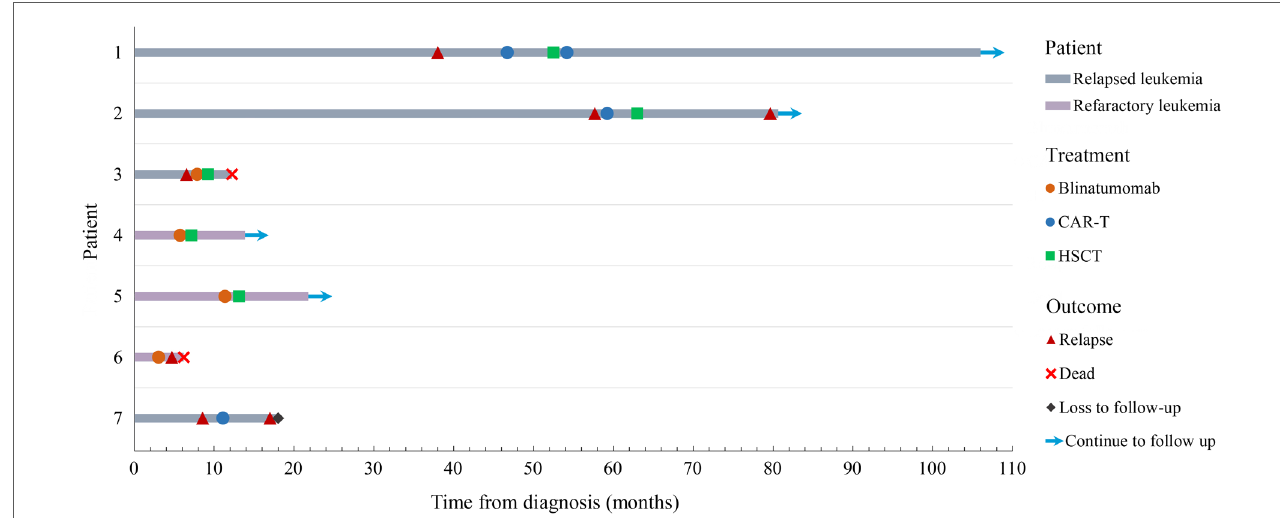
FIGURE 2 Swimmer plot of patients ’ treatment and